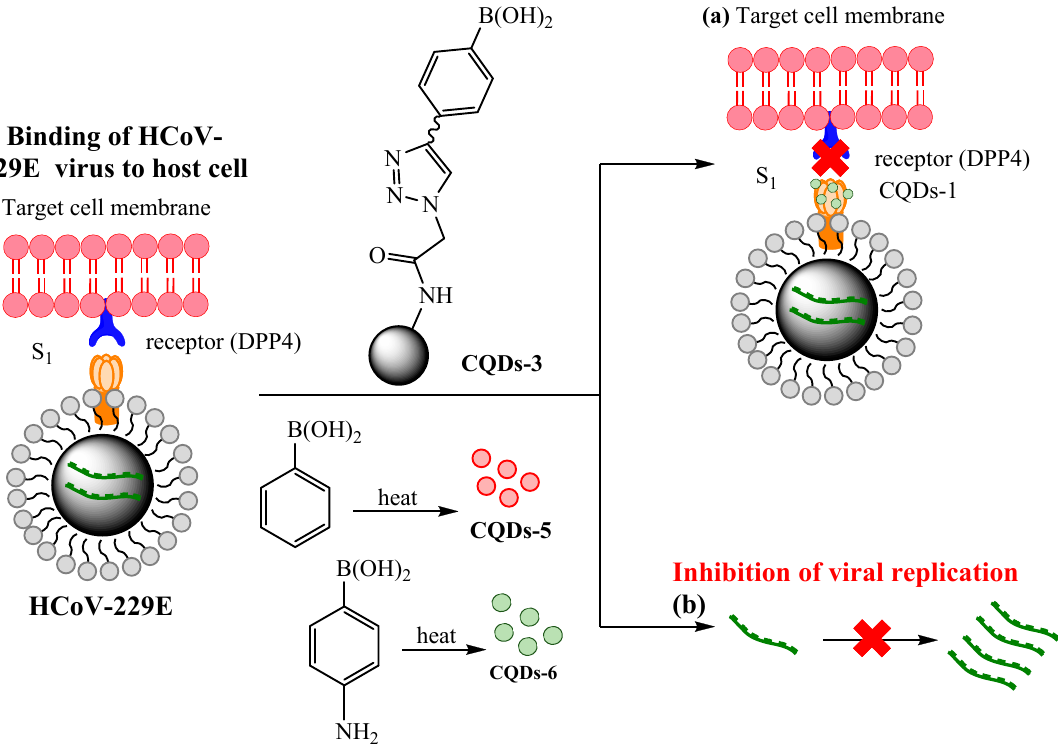
Figure 8. Carbon quantum dots (CQDs) prepared using hydrothermal carbonization and their influence on binding of HCoV-229E virus to cells: ( a ) inhibition of protein S receptor interface, ( b ) inhibition of viral RNA genome replication. Redrawn with permission from [57]. Copyright © 2020 , American Chemical Society.